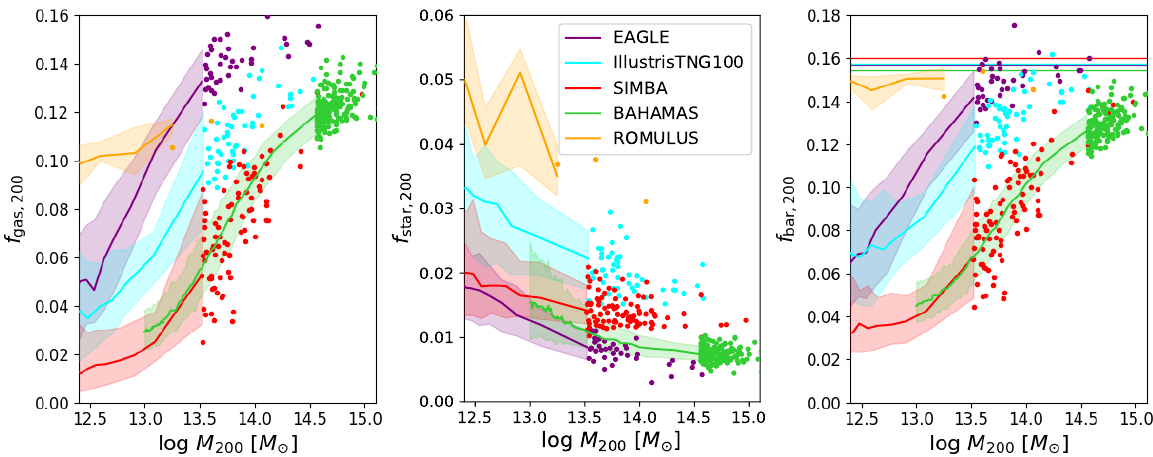
Figure 3. Gas, stellar and combined baryon fractions inside R 200 from a variety of widely-used, contemporary cosmological hydrodynamic simulations. Medians and 1- σ spreads are shown with lines and shading up to a mass where individual objects are plotted as points. The cosmic baryon fraction f b = Ω b / Ω M is plotted in the right-hand panel for the given simulation cosmology. IGrM measurements rarely extend to R 200 , therefore this plot does not include observations. It is notable that stellar contents do vary by a factor of more than 3 between different simulations in the group regime, × and more than double between EAGLE and IllustrisTNG. ROMULUS retains almost all of its baryons within R 200 while BAHAMAS and SIMBA eject more than half their baryons at M 200 (cid:46) 10 13.5 M . For reference, M 500 is typically 0.16 dex (cid:12) lower than M 200 for this halo mass